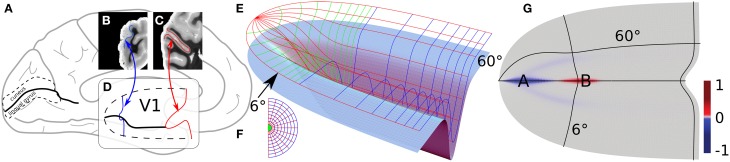
Principal folding pattern correlating with a cortical area defined by a functional field. Modified from study by Dahlem and Tusch (2012). (A) Medial side of the brain. One the occipital pole to the left, the calcarine sulcus is marked (think black line). (B,C) Coronal section through the occipital pole. Blue and red line traces the stria of Gennari as a marker of the primary visual cortex (V1), which is outlined in (A) by a dashed line. (D) Gross 3D shape of V1, about two-thirds of the surface area lie within the CS walls. The ventral and dorsal half of V1 are assumed to be symmetric with respect to the fundus, in particular, they extend equally long into the anterior direction, the shape of the walls are approximated with smooth profiles (see study by Dahlem and Tusch (2012) for details). (E) Light blue surface as in (D) with the retinotopic grid on top. (F) Visual field polar coordinates. (G) Gaussian curvature of V1.